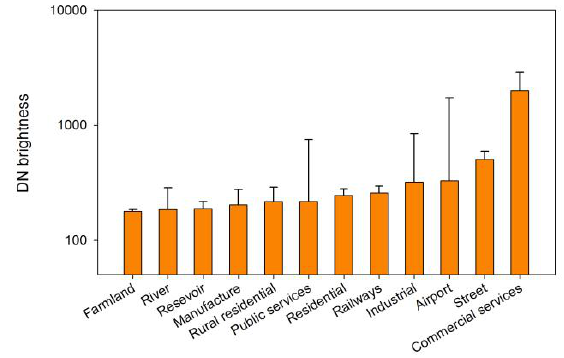
Figure 6. Digital number (DN) brightness for each land use type.